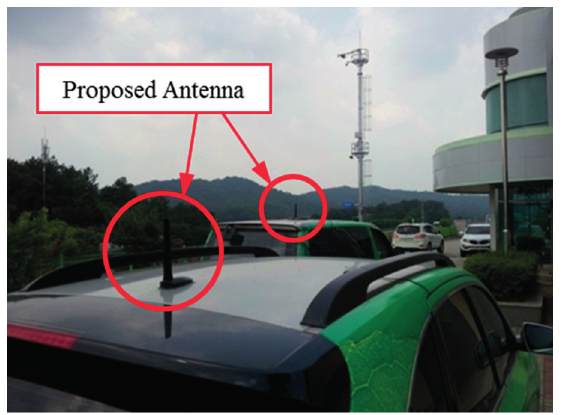
Figure 12. Proving ground for vehicle-to-vehicle and vehicle-to-infrastructure (V2X) communication measurement with the proposed